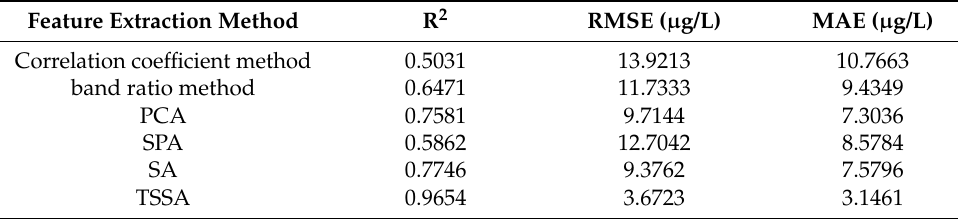
Table 2. Comparison of modeling accuracy of six feature extraction